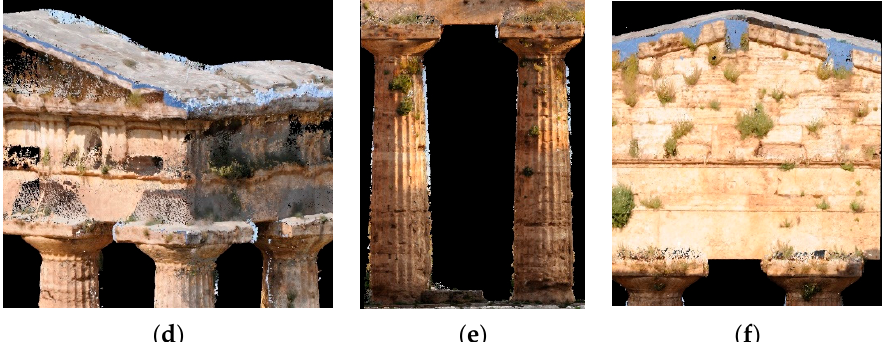
Figure 11. Qualitative evaluation and comparisons of the dense point clouds derived from the standard photogrammetric workflow ( a – c )) and after the proposed filtering method ( d – f ). 4.1.3. The World War I (WWI) Fortification of Mattarello (Trento, Italy)